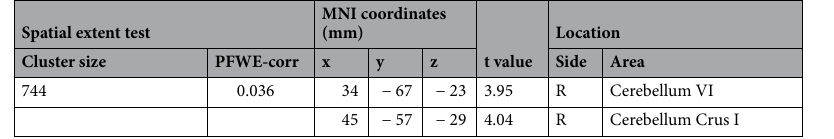
Table 1. Regions associated with processing in non-native learners and native speakers. Activation was set at a threshold of p < 0.05 and FWE was corrected for multiple comparisons over the whole brain, with the height threshold set at p < 0.001, uncorrected. The terms x, y, and z represent the stereotaxic coordinates (mm). R, right hemisphere; L, left hemisphere; IFG, inferior frontal gyrus; SFG, superior frontal gyrus; ACC, anterior cingulate cortex; MCC, middle cingulate cortex; mPFC, medial prefrontal cortex; MTG, middle temporal gyrus; FWE, family-wise error; MNI, Montreal Neurological